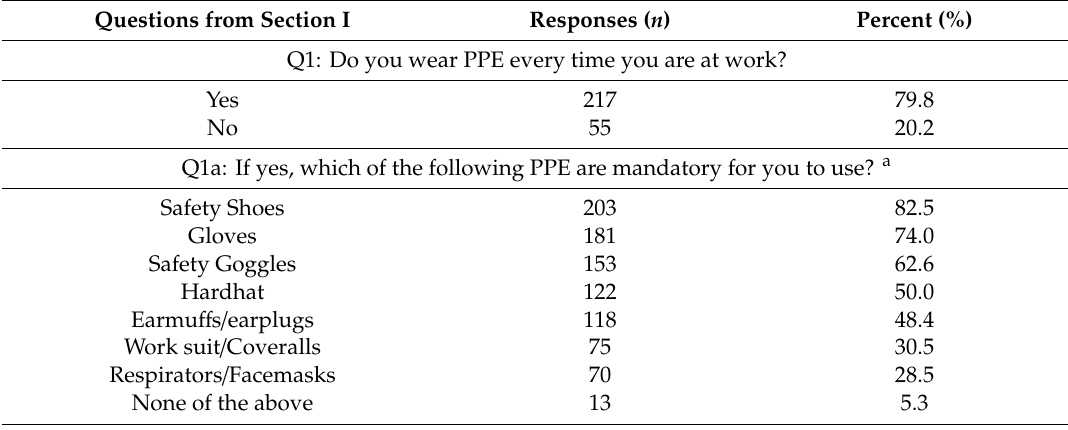
Table 2. Assessment of PPE compliance and knowledge of occupational exposures at the participant’s wastewater facility ( n =